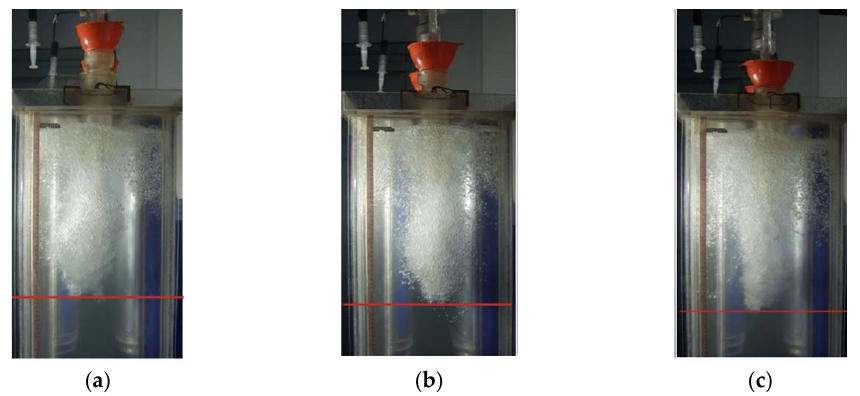
Figure 9. Flow patterns at varied funnel immersion depths: ( a ) 70 mm; ( b ) 90 mm; ( c ) 110